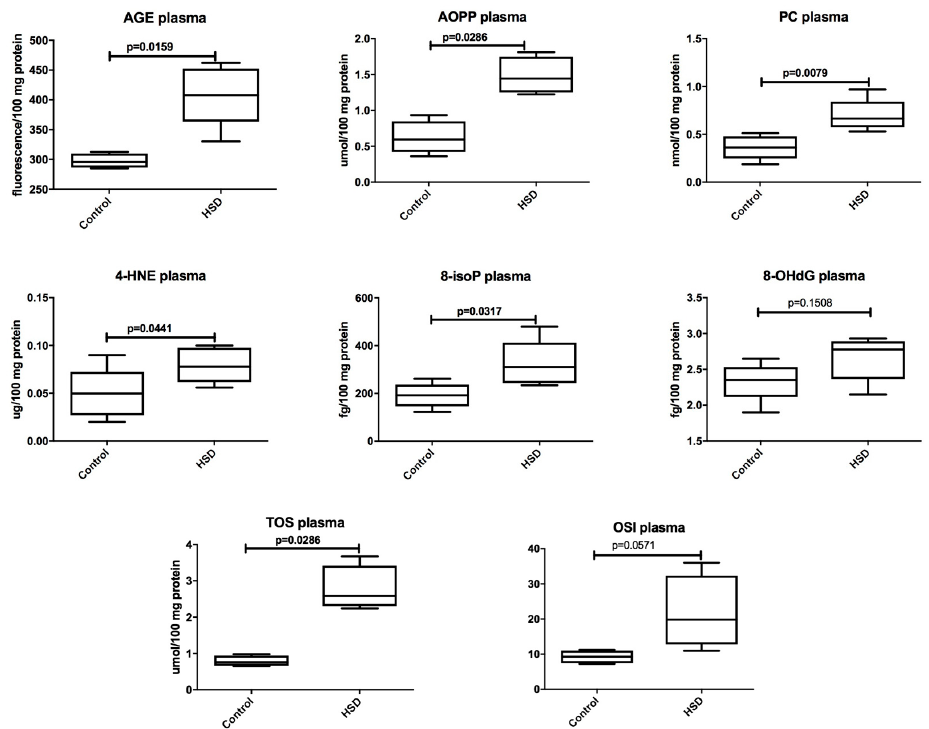
Figure 3. The effect of a high-sucrose diet (HSD) on plasma oxidative damage. Abbreviations: 4-HNE, 4-hydroxynonenal protein adducts, 8-isoP, 8-isoprostanes, 8-OHdG, 8-hydroxy-2 ′ -deoxyguanosine, AGE, advanced glycation end products, AOPP, advanced oxidation protein products, OSI, oxidative stress index, PC, protein carbonyls, TOS, total oxidant status.